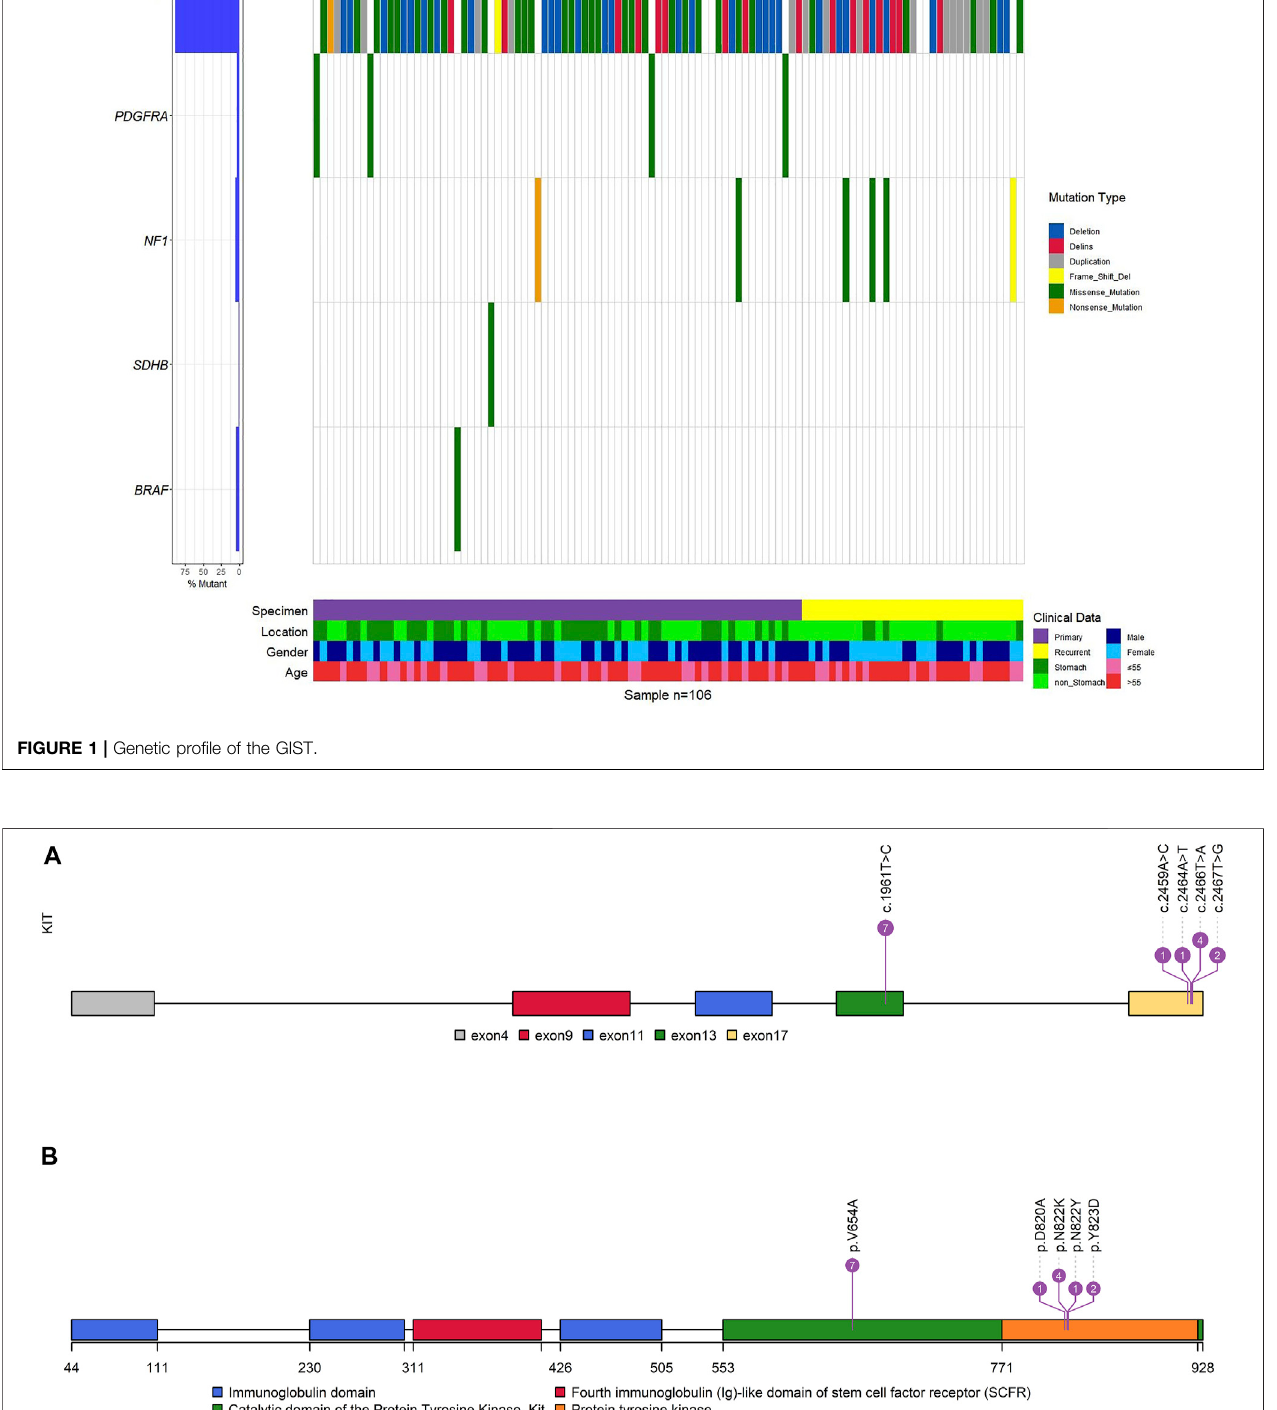
Frontiers in Genetics |